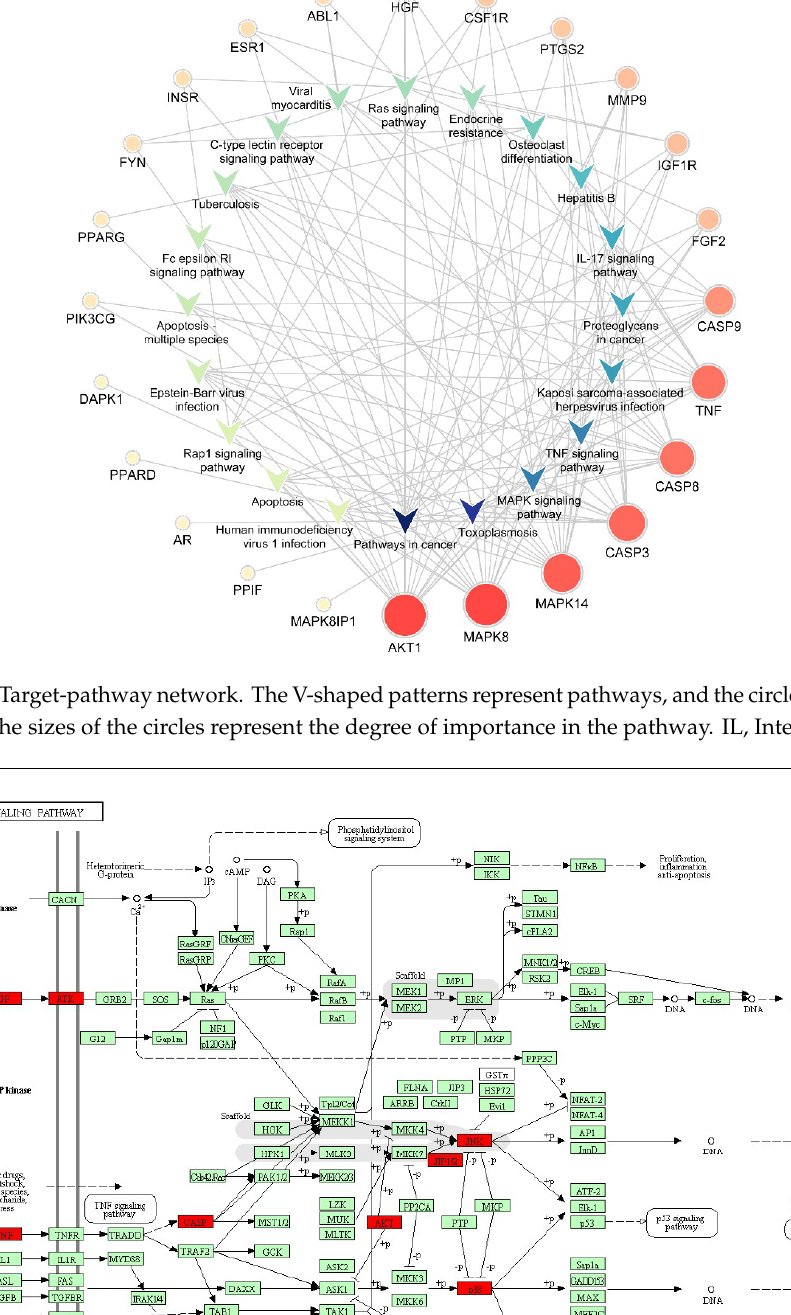
Figure 2. Kyoto Encyclopedia of Genes and Genomes (KEGG) pathway and gene ontology enrichment analyses of 29 target proteins ( p -value ≤ 0.05). ( A ) The top 20 KEGG pathways. ( B ) The top 20 biological processes. ( C ) The top 20 molecular functions. ( D ) Eleven cellular components. The color scales indicate the different thresholds for the p -values, and the sizes of the dots represent the number of genes corresponding to each term.